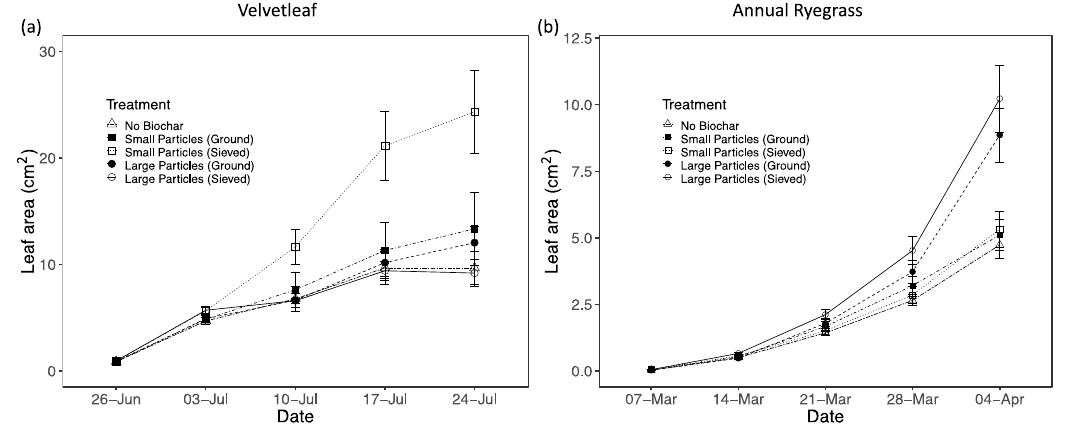
Figure 6. Leaf area growth of velvetleaf ( a ) and annual ryegrass ( b ) by treatment. Means are plotted ± 1 SE based on measurements on 7 replicates for each treatment by species